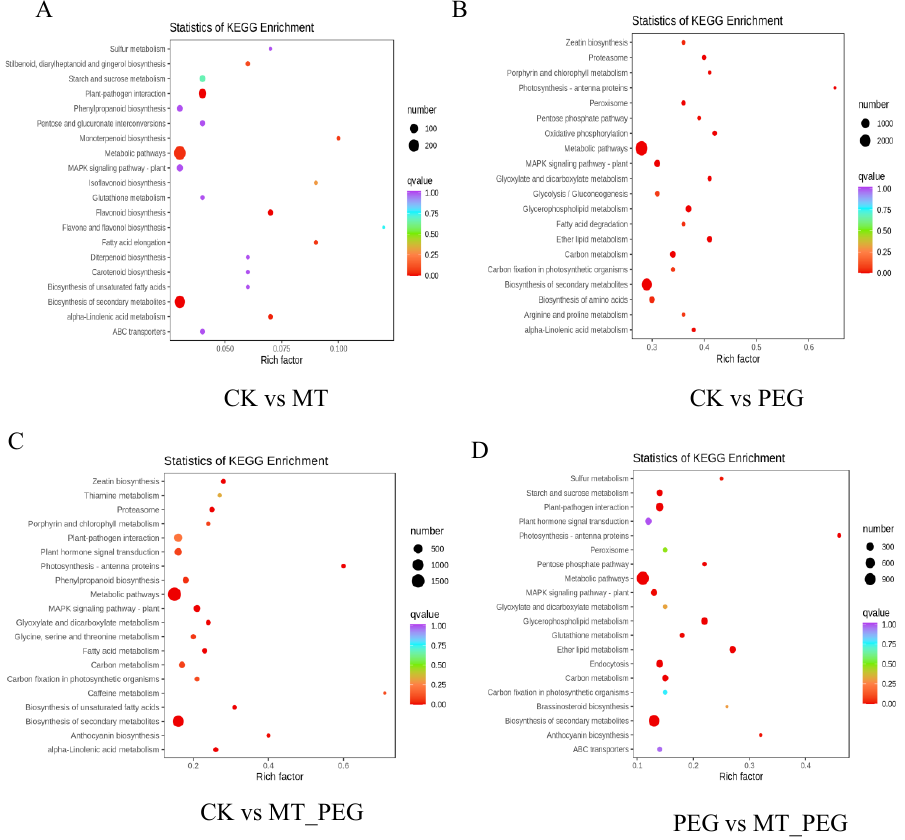
Figure 6. Enrichment scatter plot of KEGG pathways of DEGs identified from the comparisons of the four groups (CK vs. MT, CK vs. PEG, CK vs. MT_PEG, PEG vs. MT_PEG). The enrichment of KEGG pathways is shown in a scatter plot. The 20 most significantly enriched pathway entries are shown in this figure by default. ( A ) KEGG pathway enrichment scatter plot of the comparison of the CK vs. MT. ( B ) KEGG pathway enrichment scatter plot of the comparison of the CK vs. PEG groups. ( C ) KEGG pathway enrichment scatter plot of the comparison group of CK vs. MT_PEG groups. ( D ) KEGG pathway enrichment scatter plot of the comparison of the PEG vs. MT_PEG groups.